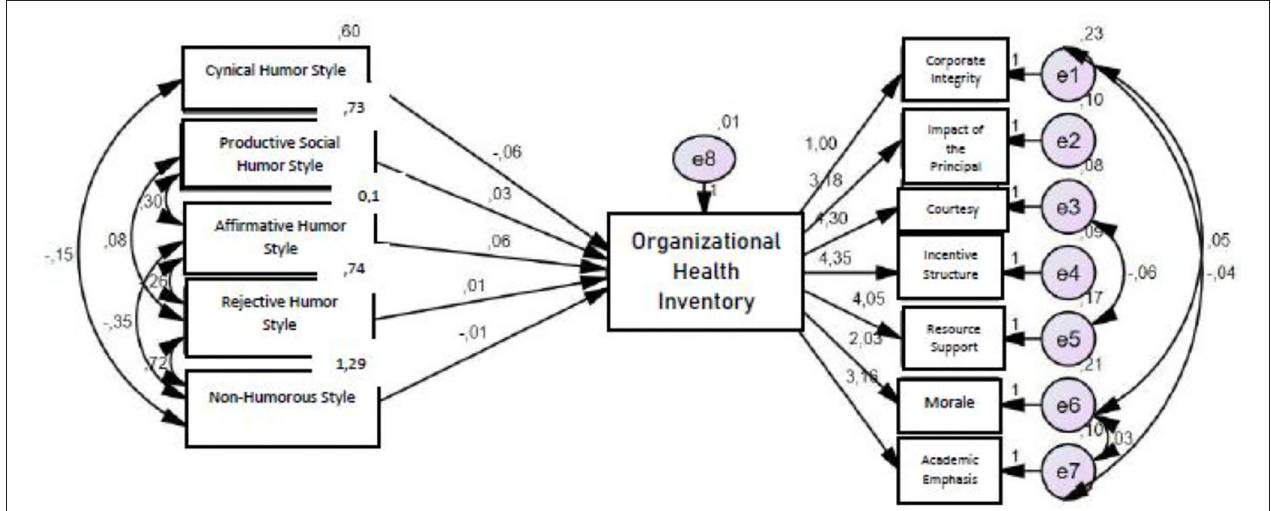
FIGURE 1 | Path analysis of the effect of teachers’ views on school principals’ humor behaviors on organizational health. The covariance between the error terms is caused by the modification indices specified by the software to increase the goodness-of-fit values of the